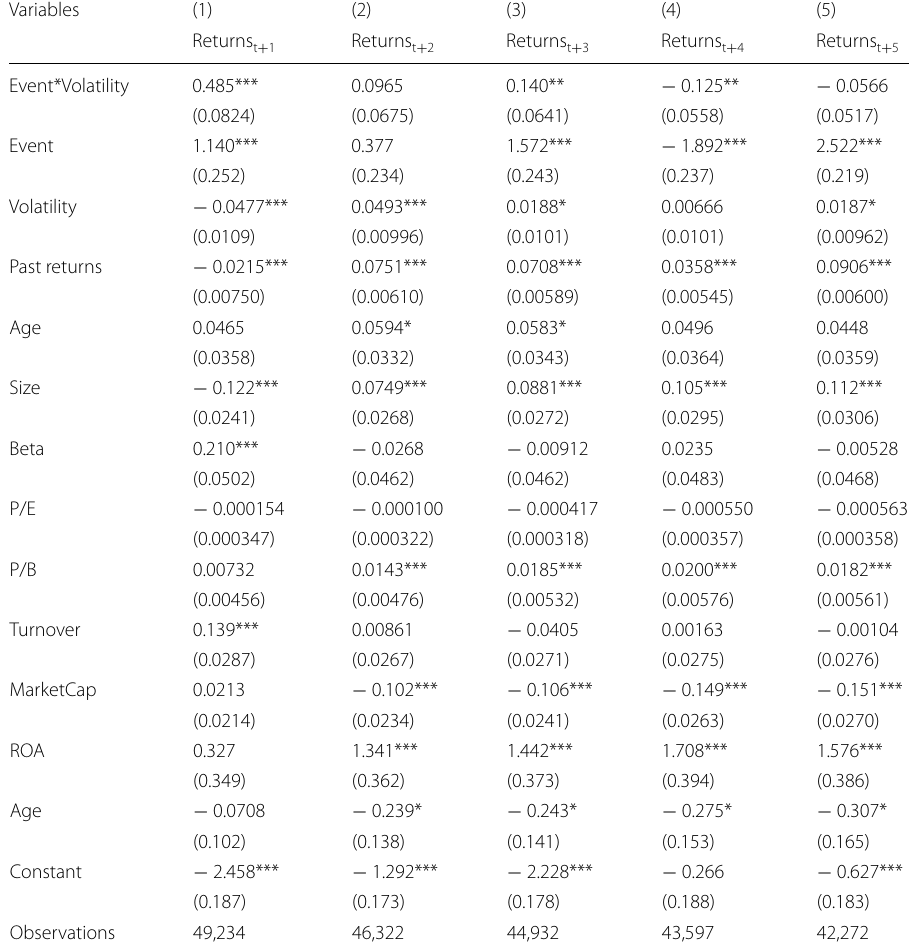
Table 4 Light a lamp, volatility and